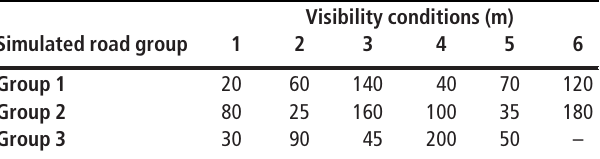
Table I Experimental group design Simulated road group